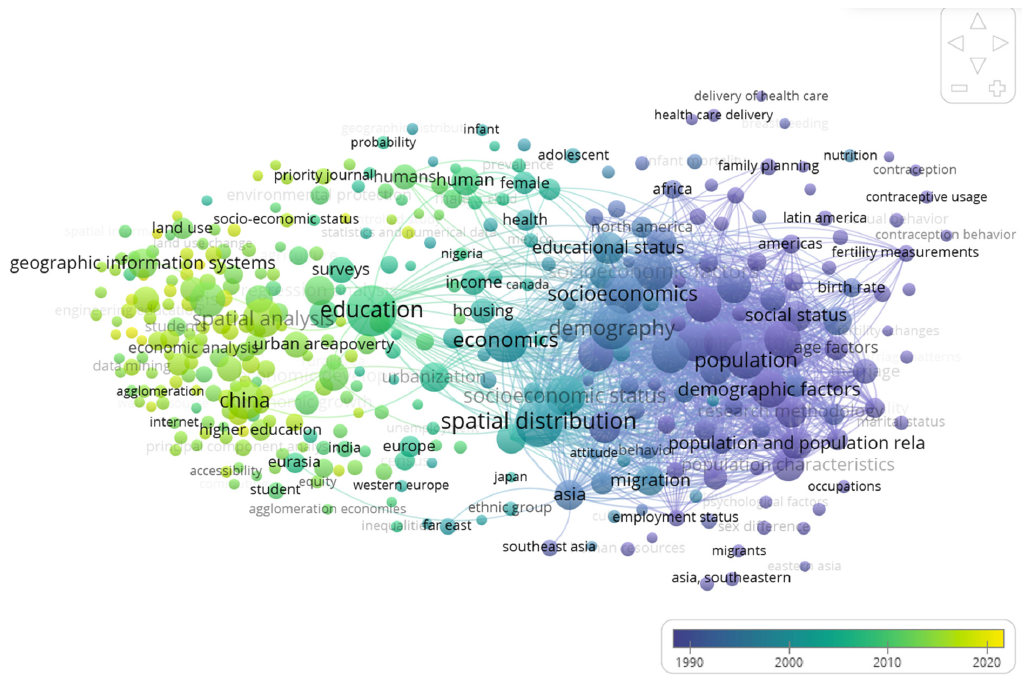
Figure 4. Bibliometric mapping with the time component analysis based on the Scopus database, 30